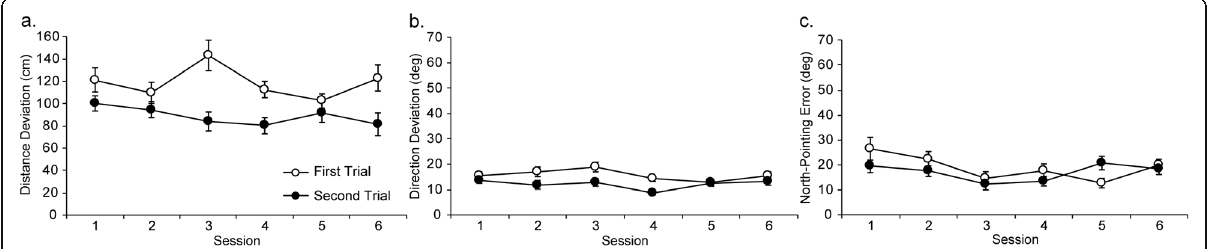
Fig. 3 Results of a repeated measures analysis of variance for the performance on training tasks: distance and direction deviations in pathway completion ( a and b , respectively) and direction errors in north pointing ( c ). Vertical lines depict standard errors of the